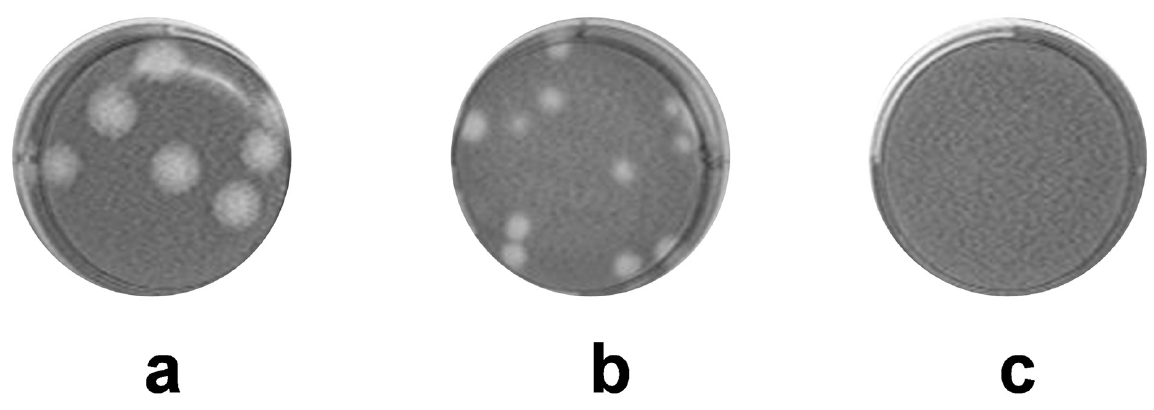
Figure 3 - Plaque assay of YFV-17D and YFV-GLuc. BHK-21 cells were inoculated with serial dilutions (10 -1 to 10 -5 ) of YFV- GLuc or YFV-17D, and plaques were revealed 7 days post-infection. a) Plaques formed by YFV-17D at 10 -5 dilution, measuring approximately 9 mm in diameter; b) Plaques formed by YFV-GLuc at 10 -4 dilution, measuring approximately 5 mm in diameter; c) Negative control (non-infected